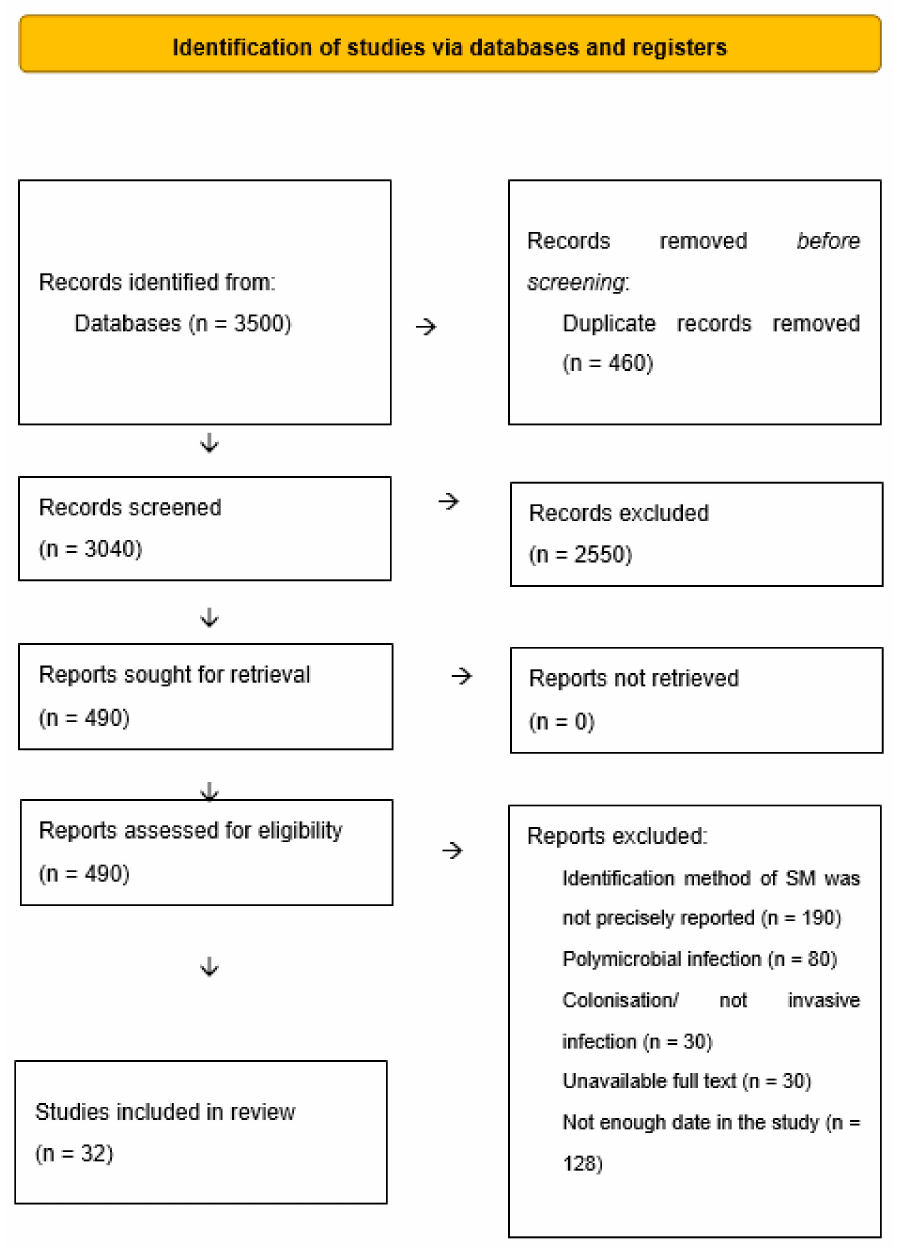
Figure 1. Selection of the